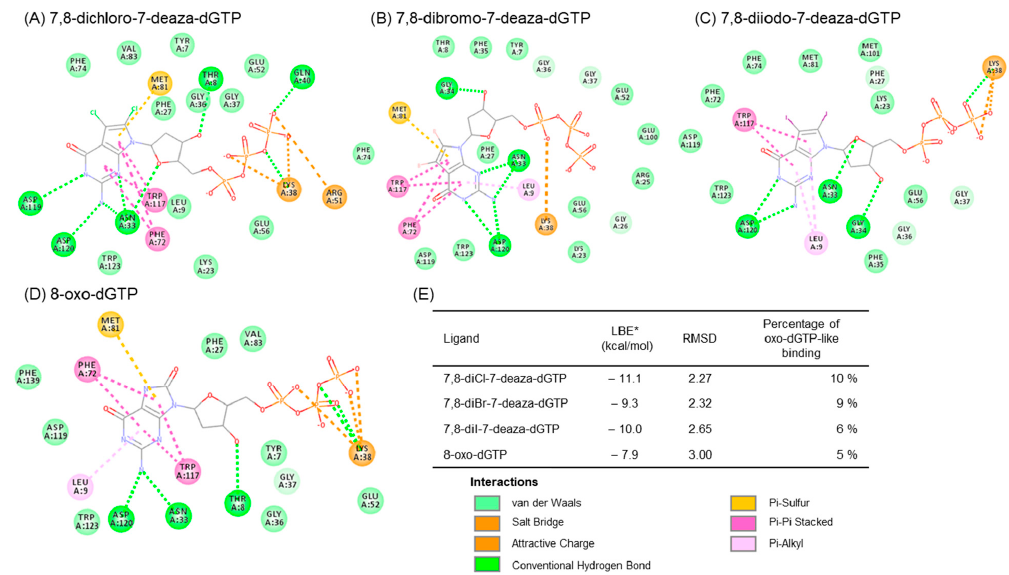
Figure 4. 2D-Interaction diagram between docked MTH1 and ( A ) 8-oxo-dGTP (PDB: 5FSI), ( B ) 7,8-dichloro-7-deaza-dGTP ( 7 ), ( C ) 7,8-dibromo-7-deaza-dGTP ( 10 ), ( D ) 7,8-diI-7-deazadGTP ( 13 ), and ( E ) and binding properties. * LBE (Lowest binding energy) value for the conformation with RMSD < 5 Å compared to the 8-oxo-dGTP moiety in the crystal structure 5FSI. Percentage of conformations with the ability to bind to the active site of hMTH1 with RMSD < 5 Å. One hundred conformations (n-100) will be generated as the docking resulting.